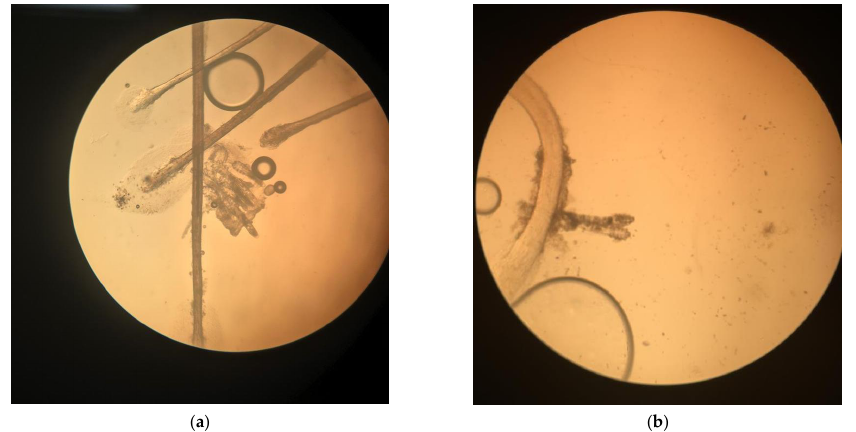
Figure 4. Demodex folliculorum ( a ) and D. brevis ( b ) under a light microscope, magnification 100×, authors’ samples.